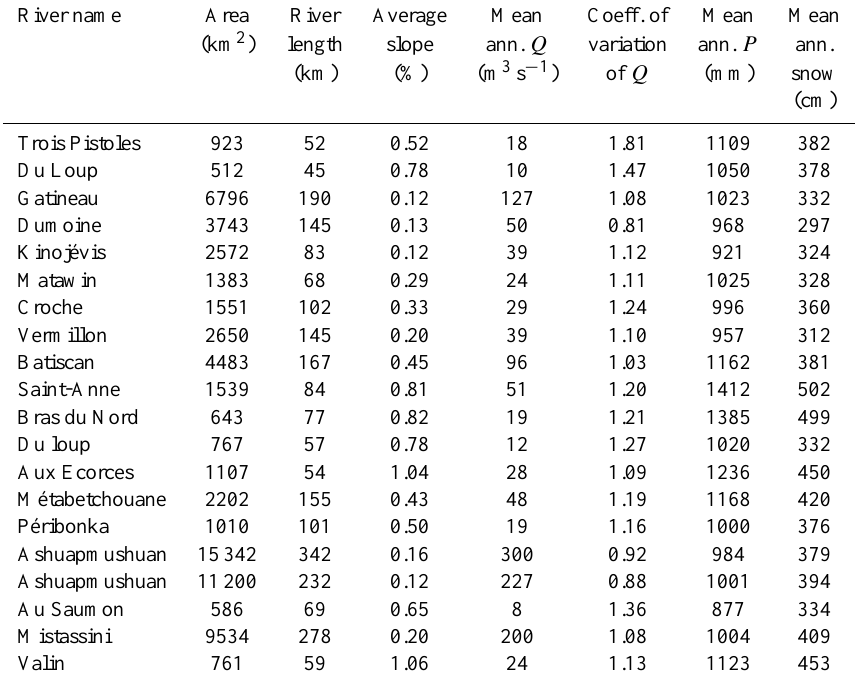
Table 1. Main characteristics of the 20 catchments. Q and P are, respectively, the observed streamflow and